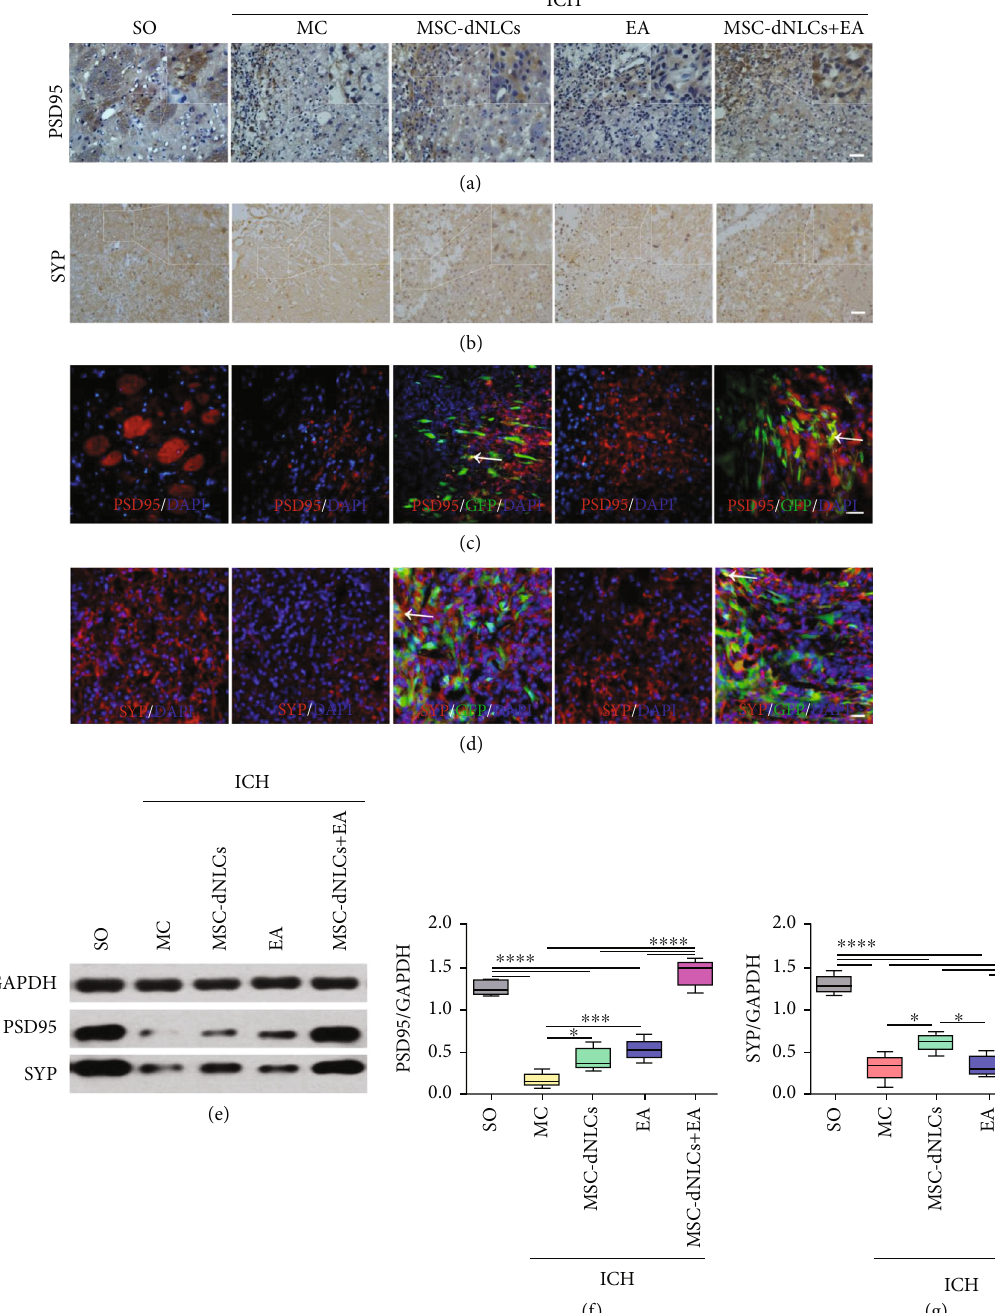
Figure 5: The expression of the PSD95 and SYP proteins in di ff erent groups. (a, b) Representative images of PSD95 (a) and SYP (b) immunohistochemical staining in the ipsilateral striatum of rats from di ff erent groups. Scale bar = PSD96 . (c, d) Representative images of PSD95 (c) and SYP (d) immuno fl uorescence staining in the ipsilateral striatum of rats from di ff erent groups. Scale bar = 100 μ m . (e – g) Representative results (e) and quantitative analyses (f, g) of western blotting showed the relative expression of the PSD95 and SYP proteins in the ipsilateral striatum of rats from di ff erent groups ( n = 5 animals per group; ∗ P < 0 : 05 , ∗∗∗ P < 0 : 001 , and ∗∗∗∗ P < 0 : 0001